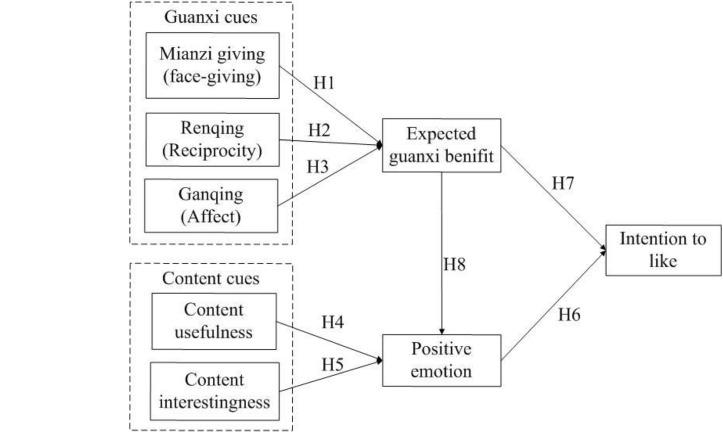
Conceptual model.